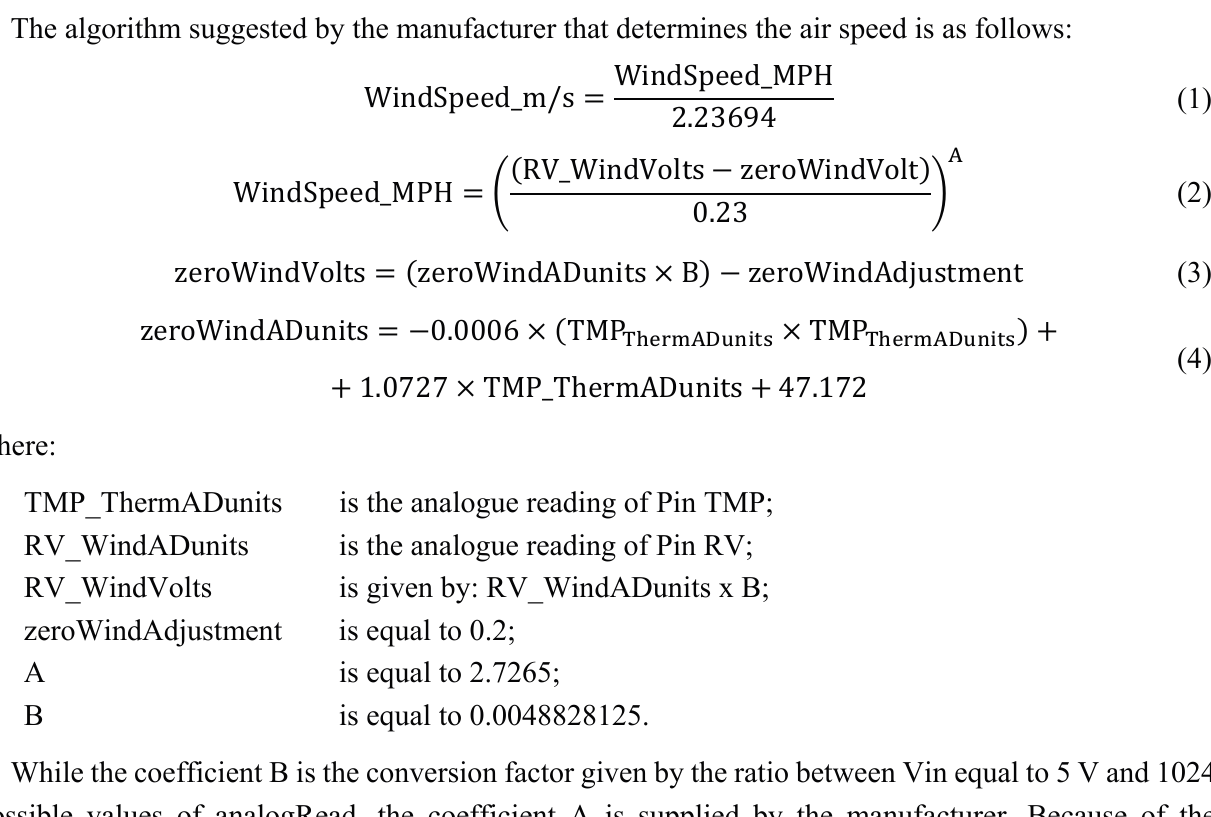
Figure 9. Air speed velocity: verification